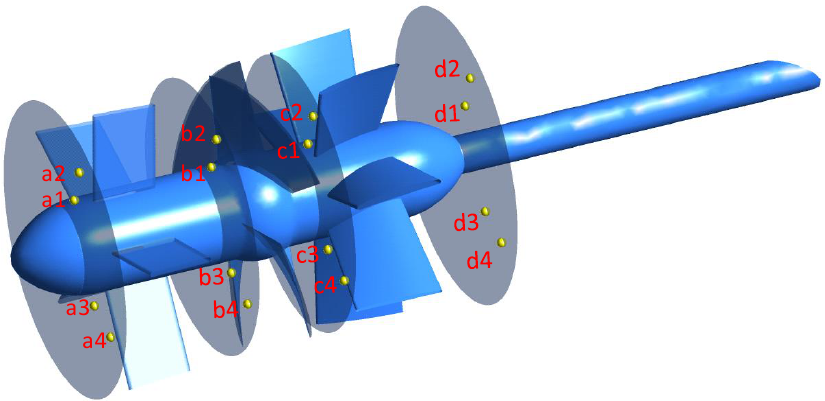
Figure 4. Layout of monitoring points on different monitoring surfaces.